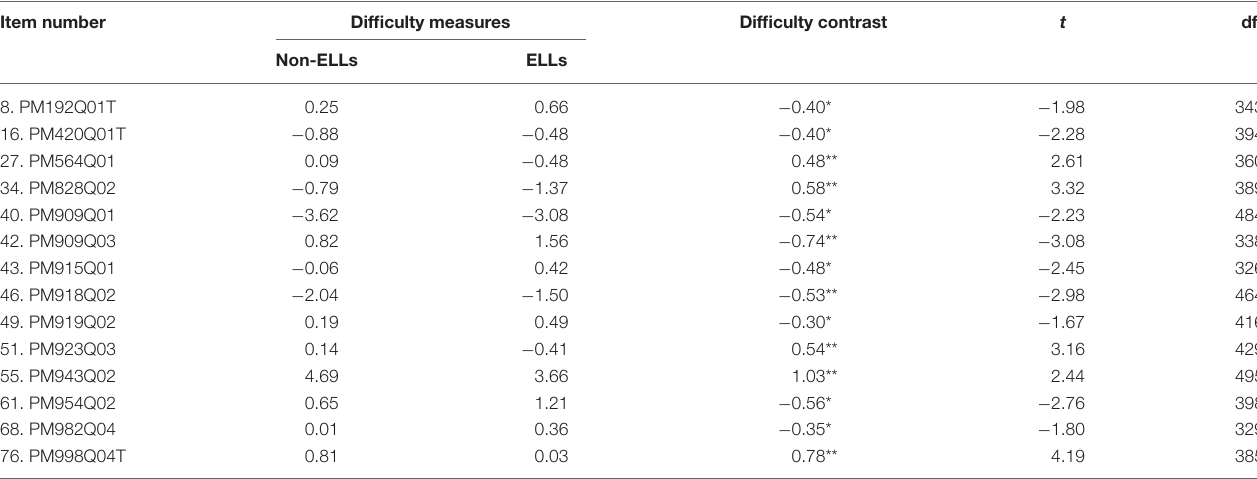
TABLE 3 | Summary of results from Rasch model to identify DIF